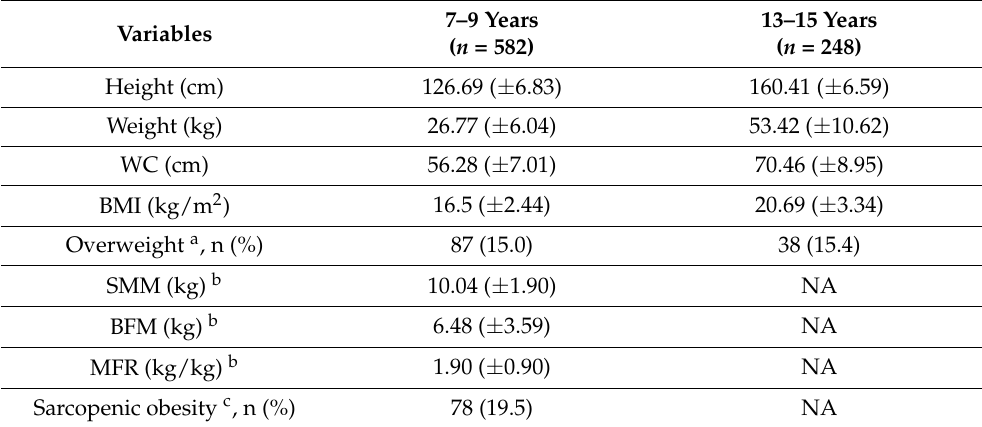
Table 1. Anthropometric and body composition characteristics of the study at 7–9 and 13–15 years